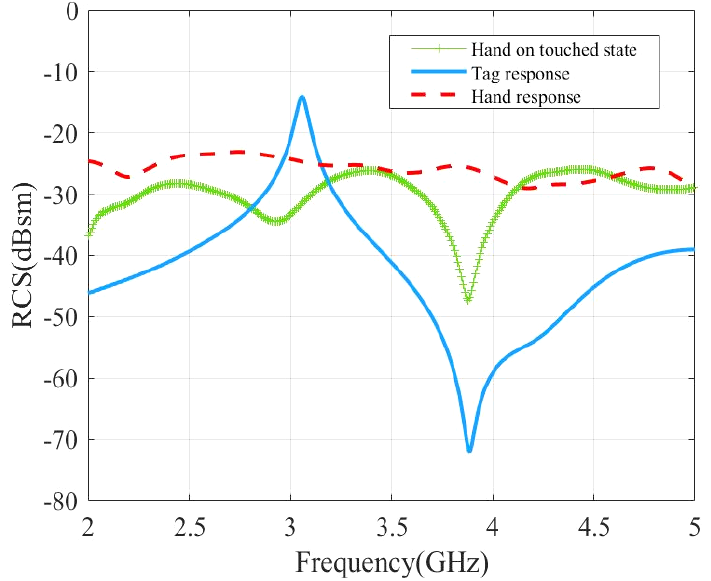
Figure 5. Simulated RCS response of the tag to study the impact of the hand touch event. Surface current distributions of the loop scatterer with and without hand touch are compared in Figure 6. In absence of the hand, the intensity of the current exhibited a sine distribution along the long strips of the loop (x direction) with zero at the center of the loop and maximum at the edges. The current was concentrated on the small arms (y direction) of the loops, for which the distribution was almost constant (infinitesimal dipole), and the current reached a maximum intensity of 0.747 A/m. When the finger was in contact with the loop, the current inside the loop vanishes (0.0163 A/m) and the loop was not resonant anymore which confirms the disappearance of the peak, as observed in Figure 5.